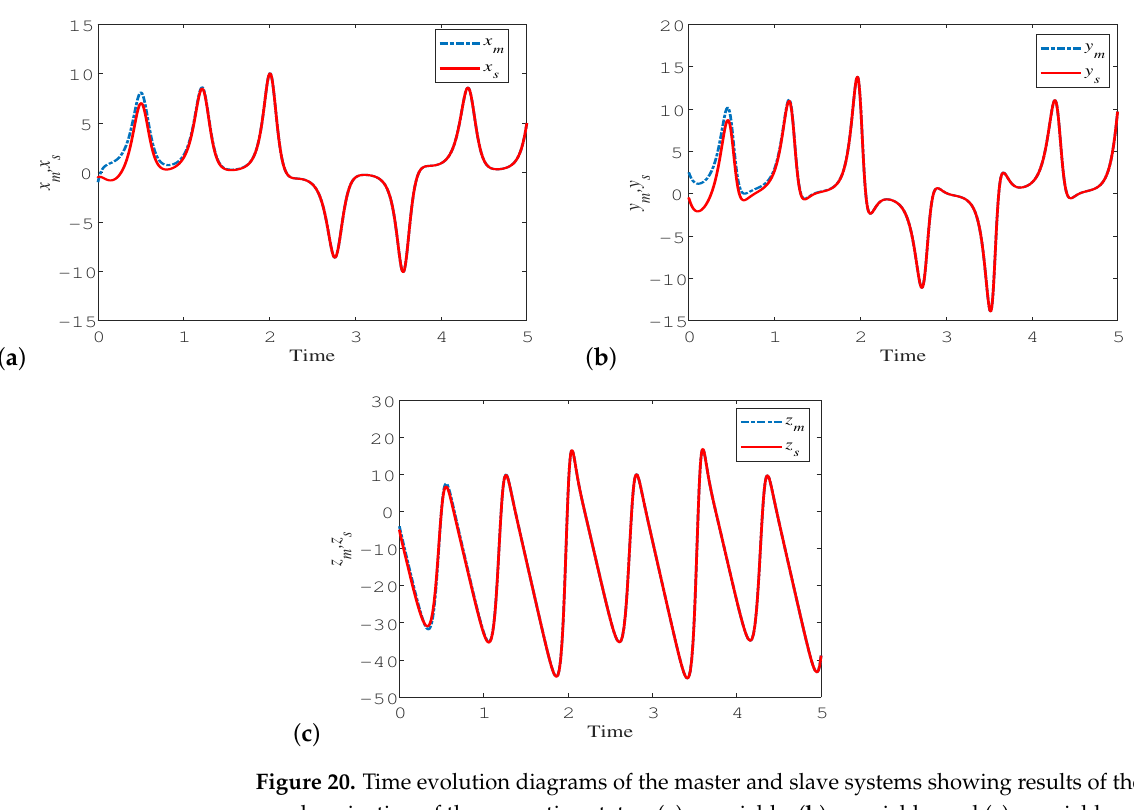
Figure 20. Time evolution diagrams of the master and slave systems showing results of the complete synchronization of the respective states: ( a ) x variable, ( b ) y variable, and ( c ) z variable.